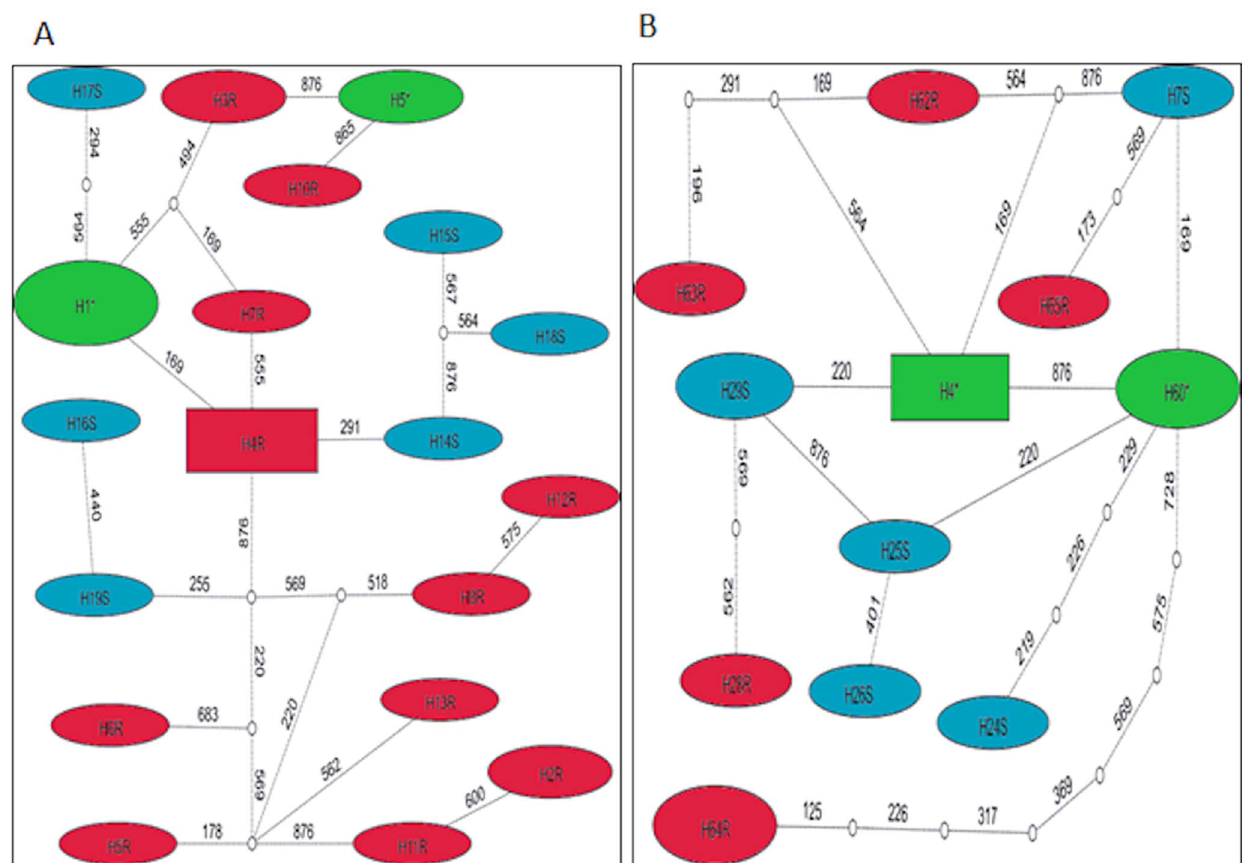
Figure 5. TCS network for the VGSC haplotypes between susceptible and resistant permethrin samples in Bulambuli (A) whereas (B) is for DDT samples in Jinja; Haplotypes are represented as an oval or a rectangle shape, scaled to reflect their frequencies. Lines connecting haplotypes and each node represent a single mutation event (respective polymorphic positions are given above branches). Blue shapes represent haplotypes unique in susceptible mosquitoes; Green shapes represent haplotypes commonly found in resistant mosquitoes and dead mosquitoes; Red shapes represent haplotypes unique to resistant mosquitoes.